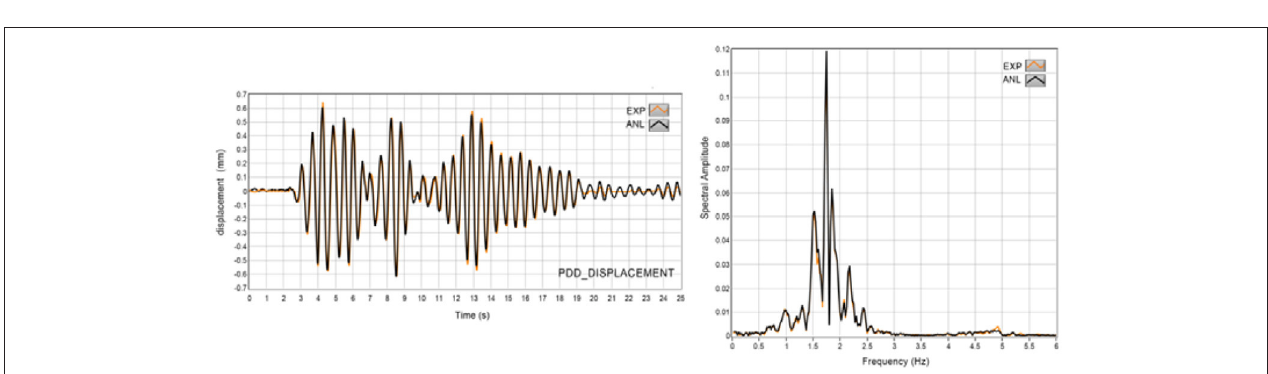
FIGURE 2 | Tested structure with different positions of dampers-MODEL02-MODEL05.